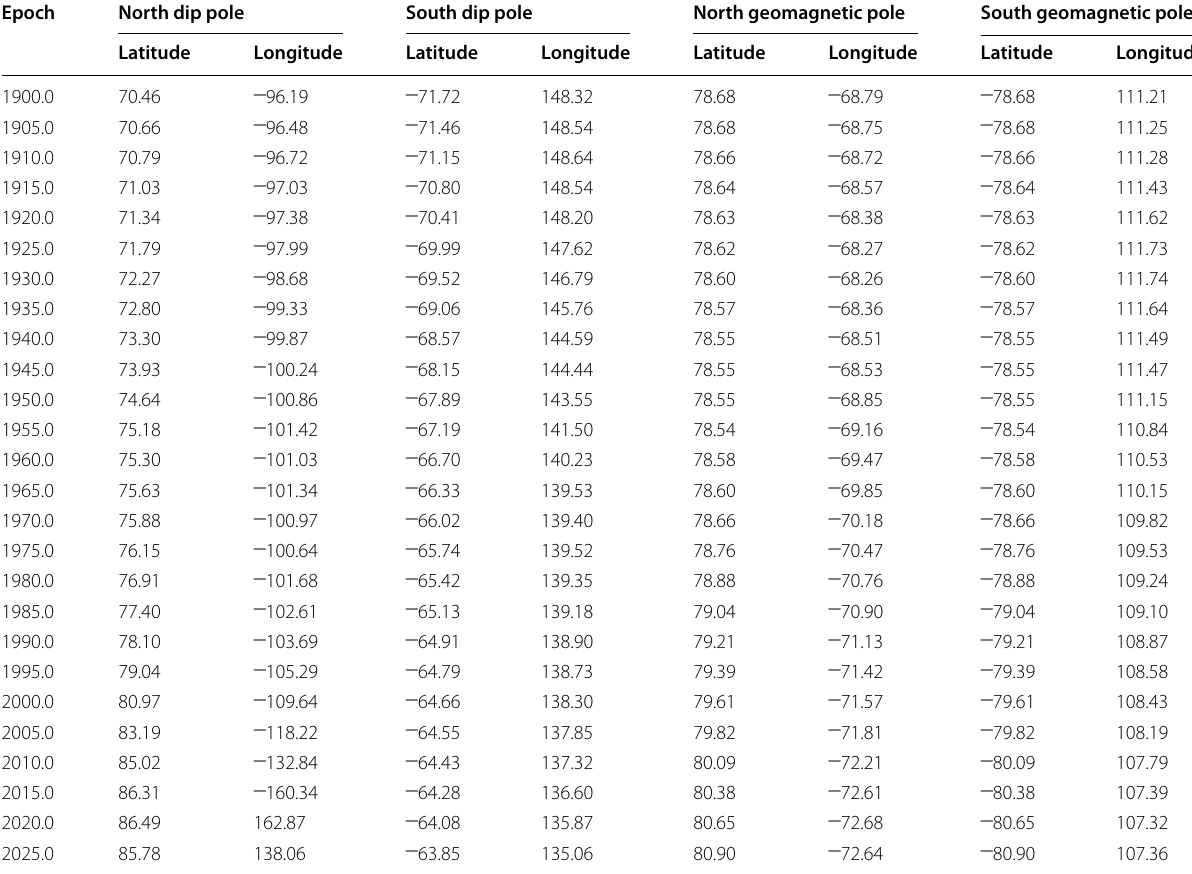
Table 4 Magnetic pole position since 1900 determined from IGRF‑13 in units of degrees. Latitudes are provided in the WGS84 geodetic system Epoch North dip